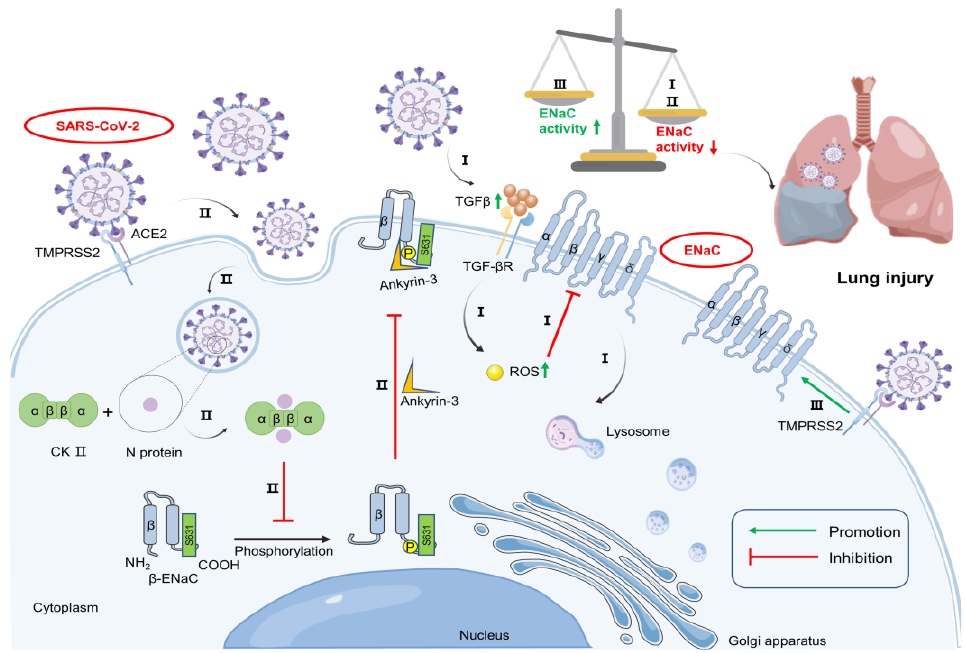
Figure 1. Mechanism diagram of epithelial sodium channel (ENaC) regulation in vivo during severe acute respiratory syndrome coronavirus 2 (SARS-CoV-2) invasion. ( I ): Elevated transforming growth factor-beta (TGF- β ) binds to receptor (TGF- βR ), causing increased reactive oxygen species (ROS) and leads to the internalization of ENaC. ( II ): SARS-CoV-2 envelope (N) protein interacts with casein kinase II (CK II) and interferes with its ability to phosphorylate and localize β -ENaC to the apical membrane side. ( III ): Transmembrane serine protease 2 (TMPRSS2) interacts with SARS- CoV-2 spike (S) protein, resulting in the diminished inhibition of ENaC. The sum effect reduces ENaC activity and leads to lung injury.